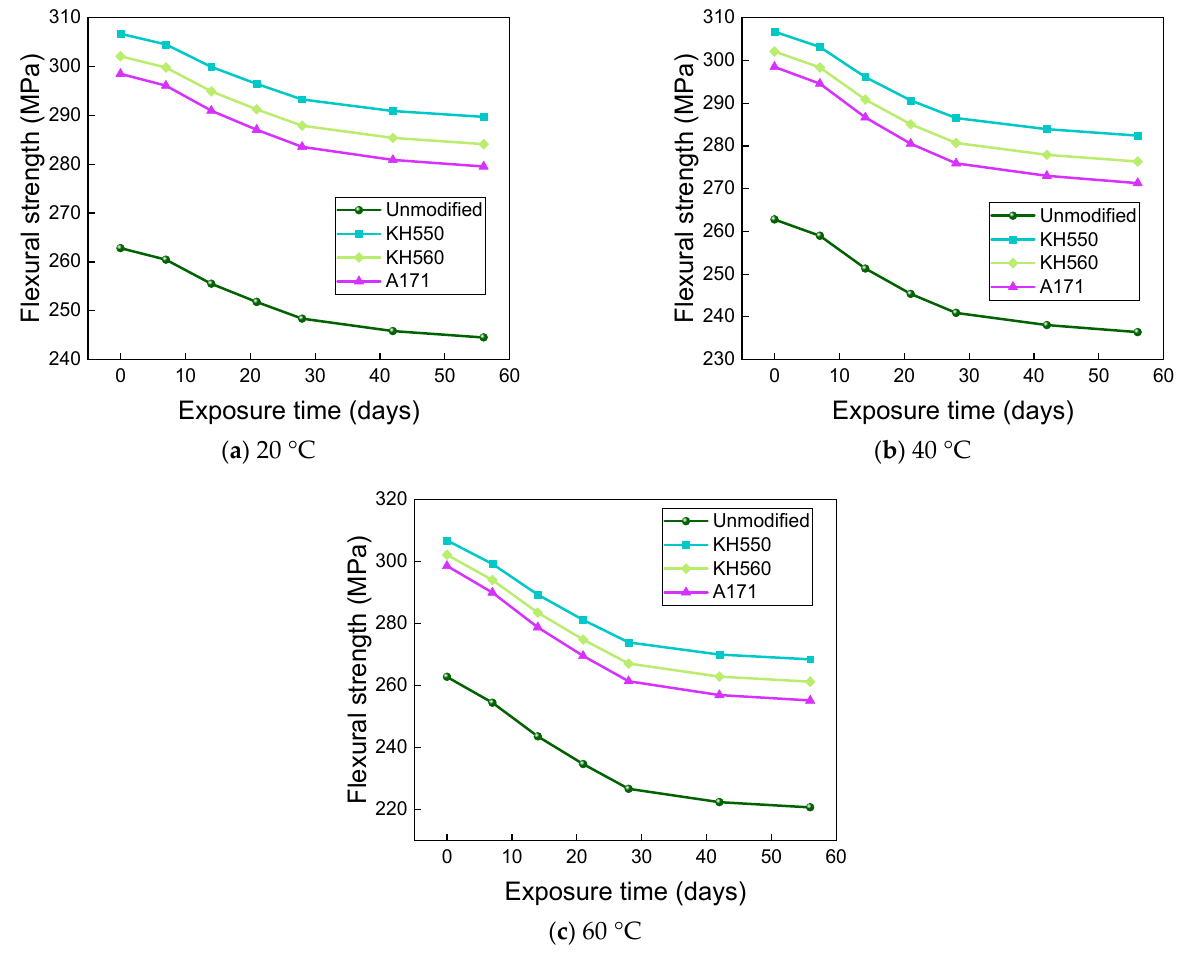
Figure 21. Flexural strength in a 3.5% NaCl seawater environment.